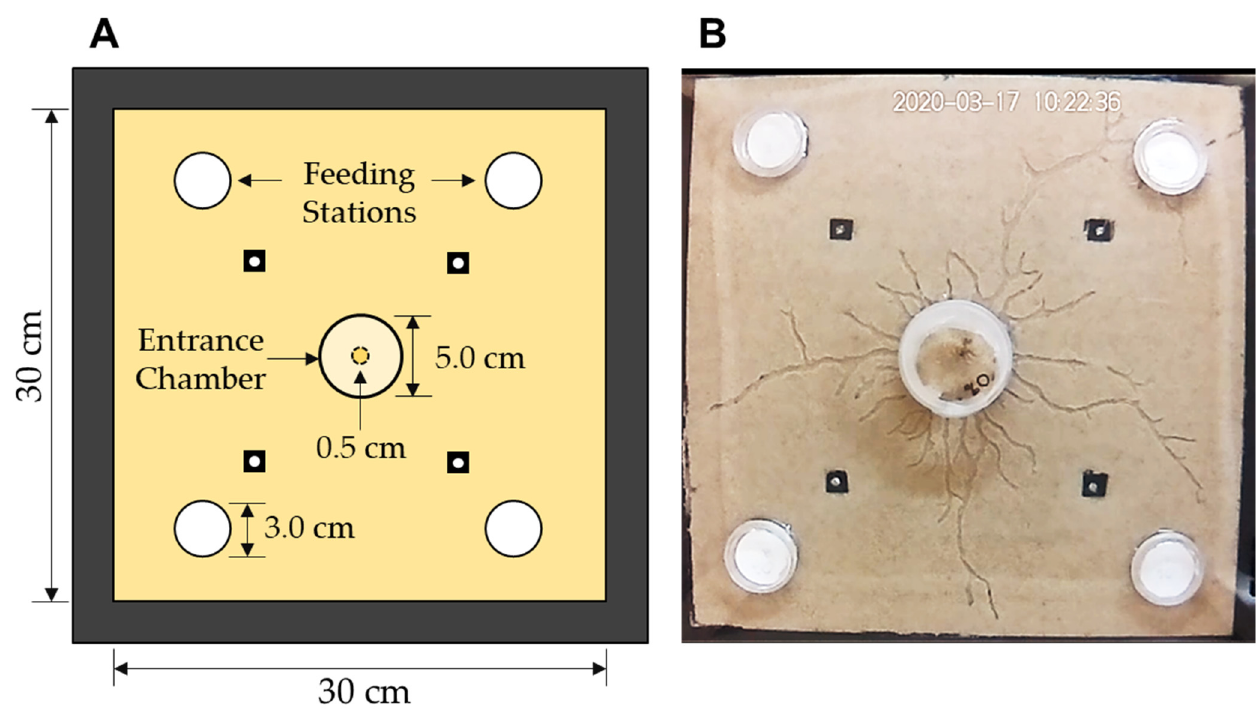
Figure 1. Experimental setup. ( A ) Foraging arena consisting of the sand substrate, four feeding stations, and a central entrance chamber; ( B ) Representative image of foraging tunnels at the end of 96 h, showing interception of one feeding station (indicated by arrow).